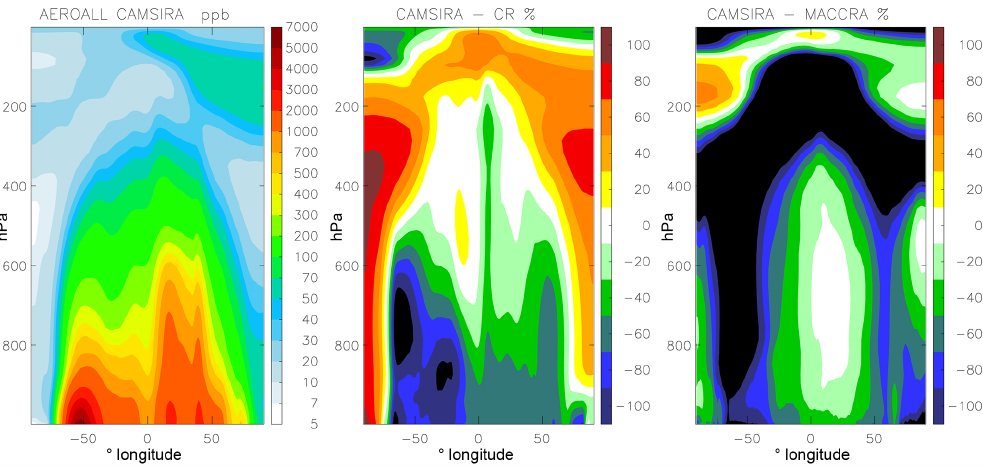
Figure 9. Zonally averaged total aerosol mass mixing ratio (10 − 9 kgkg − 1 ) of CAMSiRA (2003–2015, left) and relative difference (%) compared with the CR (2003–2015, middle) and MACCRA (2003–2012,